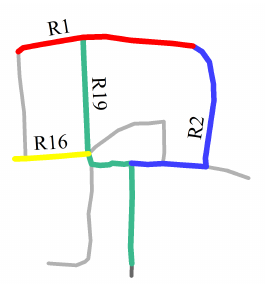
Figure 12. Roads (in color) with different curves.